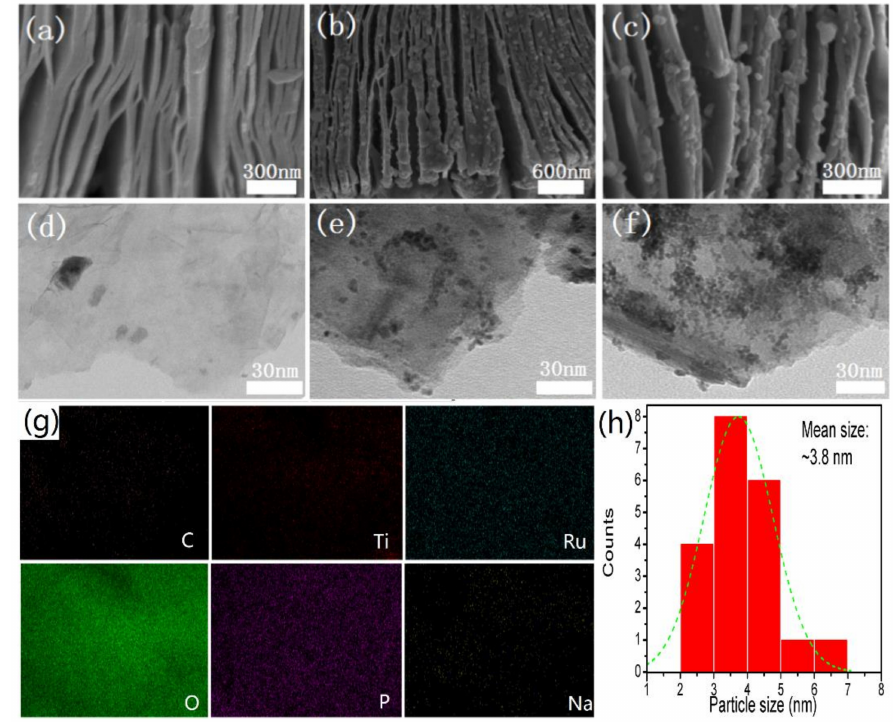
Figure 4. ( a ) SEM image of Ti 3 C 2 ; ( b ) SEM image of RuO 2 /Ti 3 C 2 ; ( c ) SEM image of PRT; ( d ) TEM image of Ti 3 C 2 ; ( e ) TEM image of RuO 2 /Ti 3 C 2 ; ( f ) TEM image of PRT; ( g ) element mapping of PRT; ( h ) size histogram of RuO 2